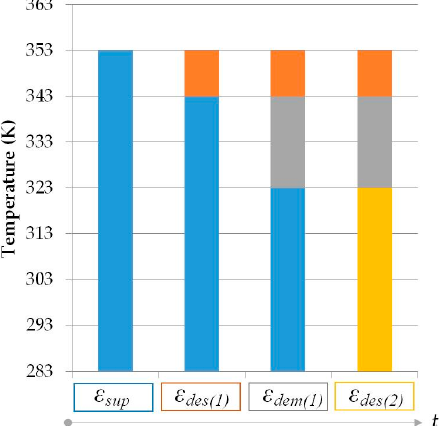
Figure 17. Exergy Flow Bars for Geothermal District Heating.